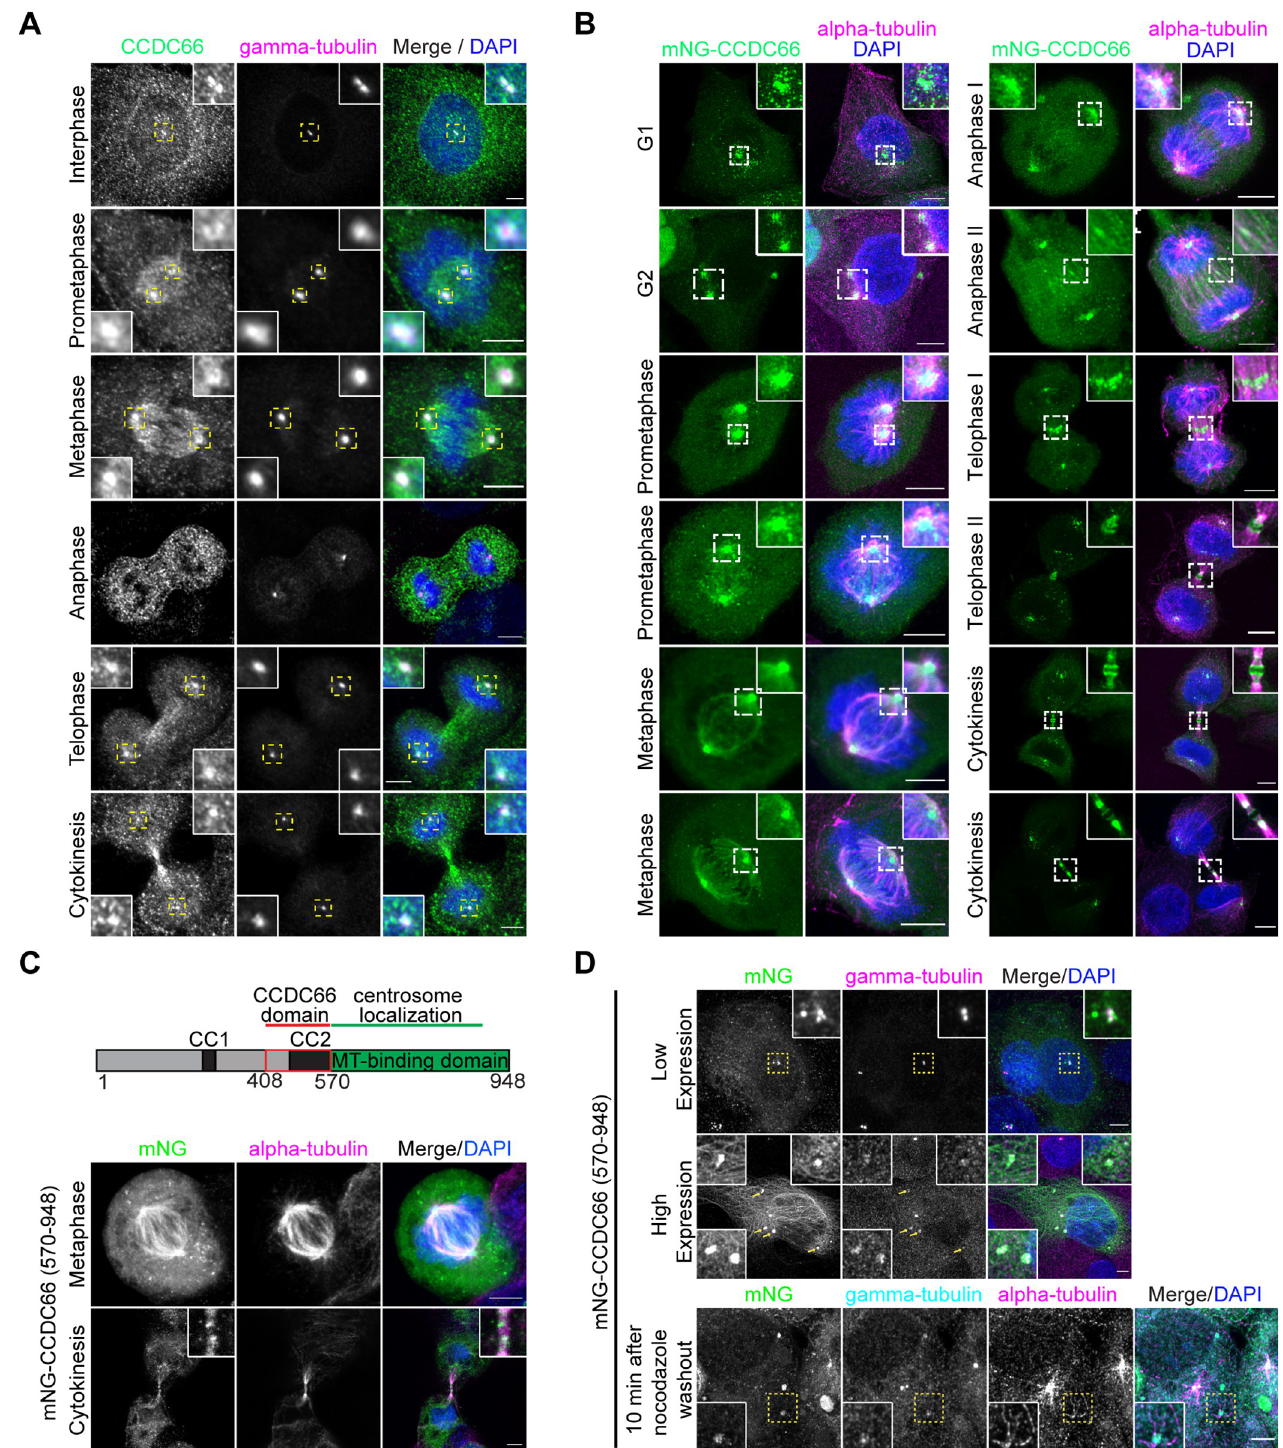
Fig 1. CCDC66 localizes to centrosomes and microtubule-based structures during cell division. (A) Localization of CCDC66 at different stages of the cell cycle. U2OS were fixed with methanol followed by acetone and stained for CCDC66, gamma-tubulin, and DAPI. Scale bar: 5 μ m, insets show 4 × magnifications of the boxed regions. (B) Localization of mNeonGreen-CCDC66 at different stages of the cell cycle. U2OS cells stably expressing mNeonGreen- CCDC66 fusion (U2OS::mNG-CCDC66) were fixed with 4% PFA and stained for alpha-tubulin and DAPI. Scale bar: 5 μ m, insets show 4 × magnifications of the boxed regions. (C) Schematic representation of FL CCDC66 domain organization. CC1 and CC2 indicate coiled-coil domains. The C-terminal region was